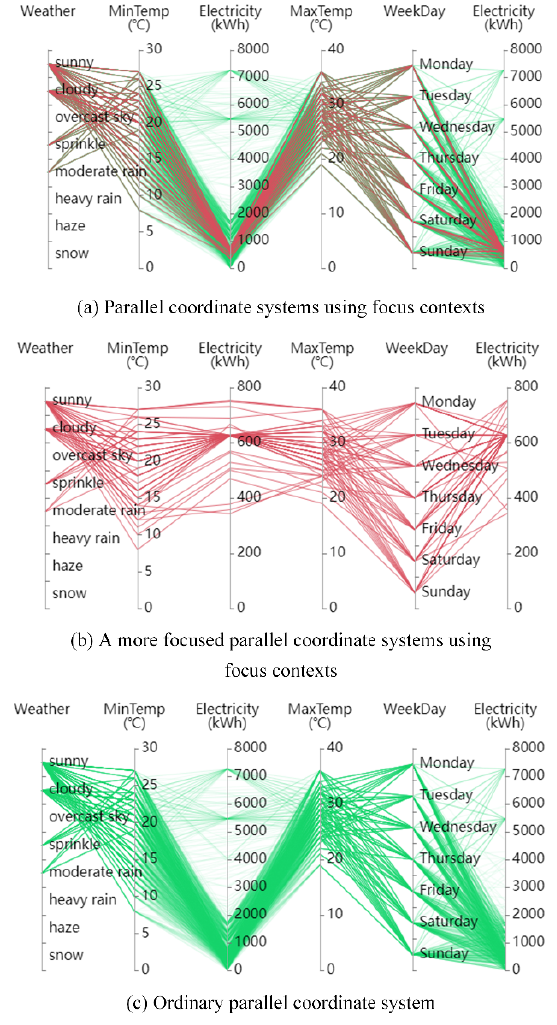
Figure 12. Correlation analysis of multidimensional data.